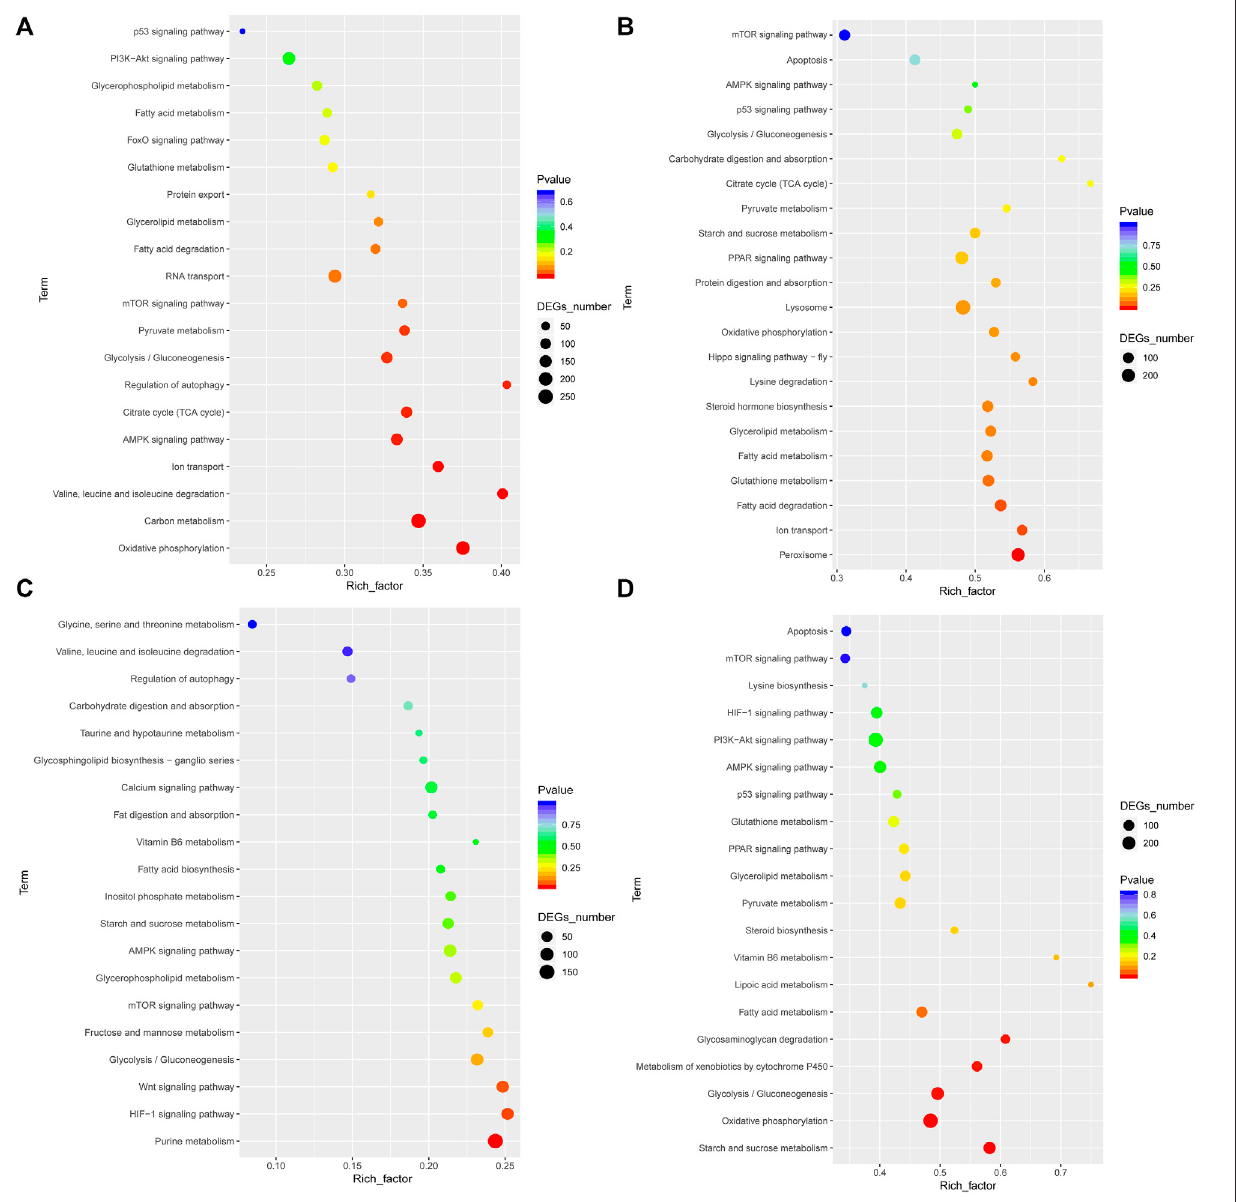
FIGURE 3 | Signi fi cant KEGG pathway classi fi cations of DEGs in the gill and hepatopancreas tissues of M. nipponense are shown for the control vs low salinity group (A,C) and for the control vs high salinity group (B,D) .